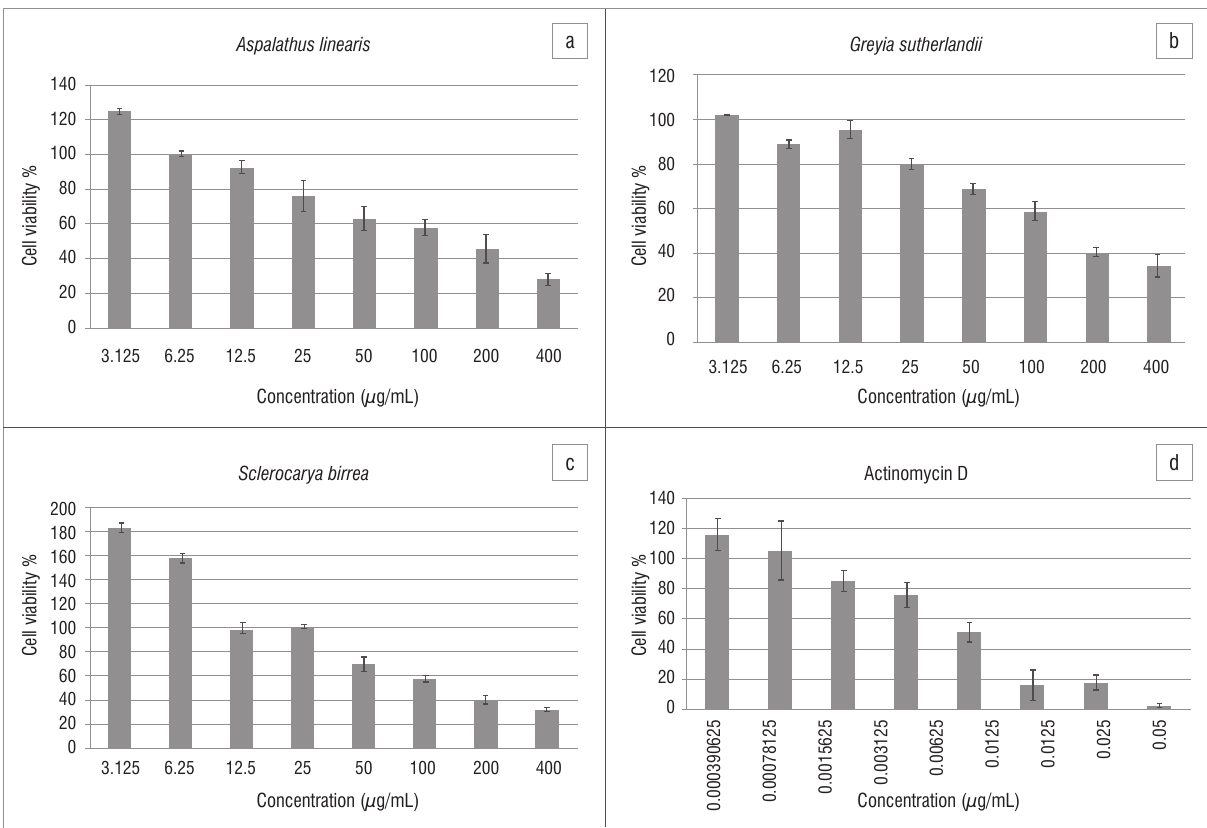
Figure 2: The cytotoxic effects of the plant extracts and the positive control (actinomycin D) on mouse melanocytes B16-F10: (a) Aspalathus linearis (EC =125.09±0.71 µg/mL), (b) Greyia sutherlandii (EC 50 actinomycin D (EC =4.5x10 -3 ± 0.5x10 -3 50